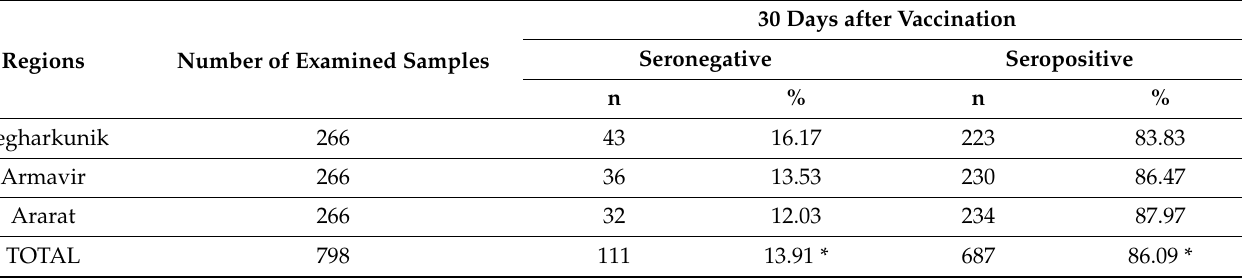
Table 3. ELISA antibody titers in cattle 30 days after vaccination with sheep pox vaccine against LSD in each of 3